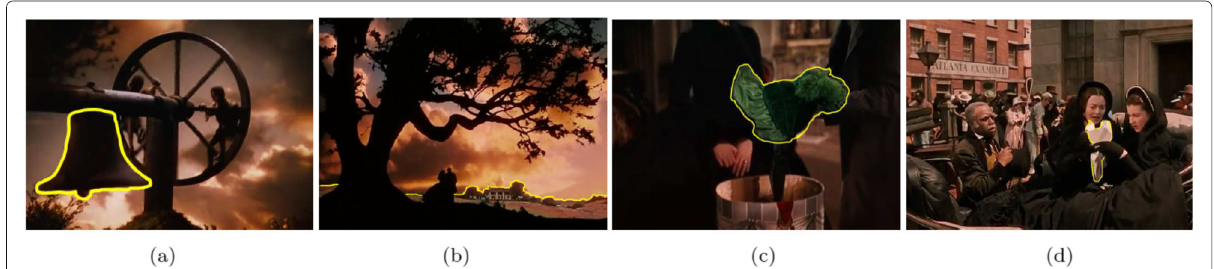
Fig. 3 Examples of COSMOROE cross-media relations in “Gone with the Wind.” a Token-Token. b Metonymy, part for whole. c Complementarity, Exophora Essential d Complementarity, Agent-Object Essential